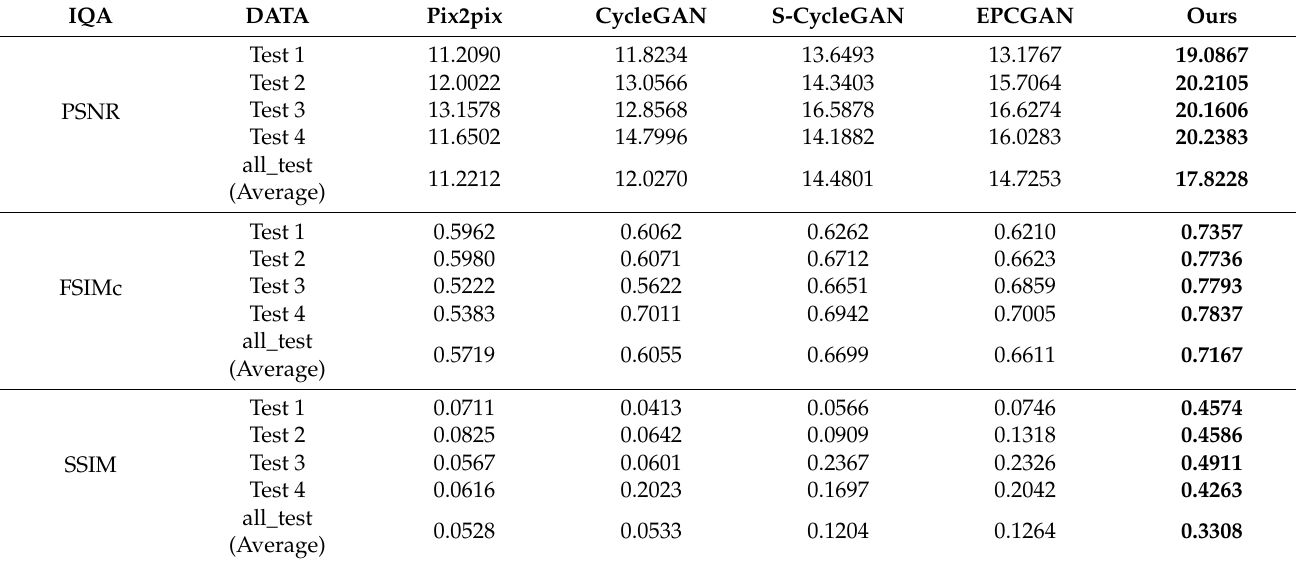
Table 2. IQA results for different methods obtained by averaging the evaluation metrics over 222 pairs of images in the test set. The best values for each evaluation index are shown in bold.